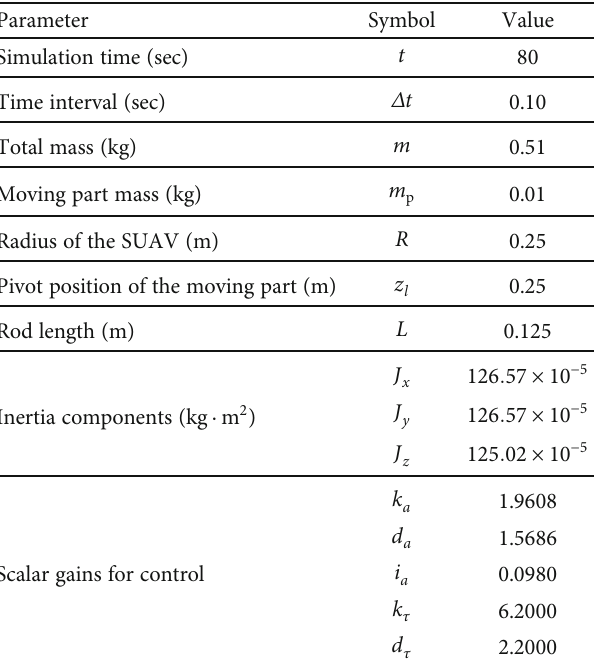
Table 2: Simulation